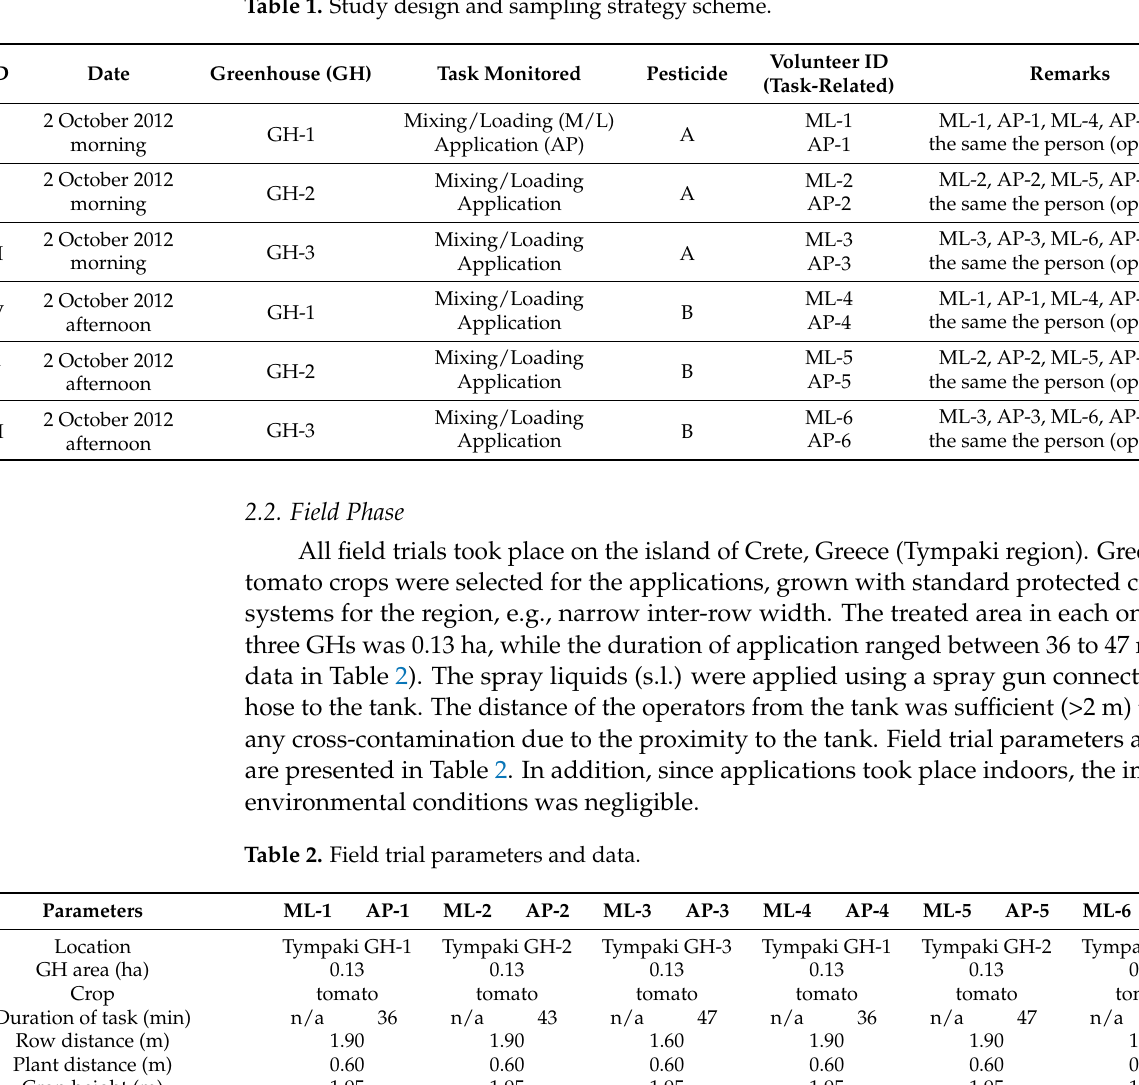
Table 1. Study design and sampling strategy scheme.